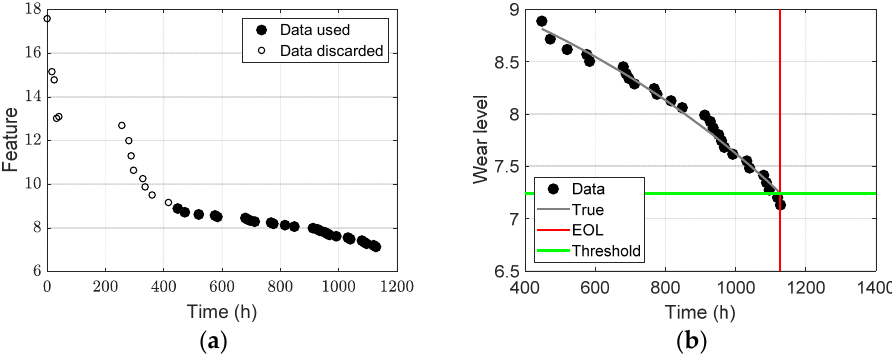
Figure 13. Given information and assumption for prognostics: ( a ) data for RUL prediction; ( b ) as- sumed true model and threshold.